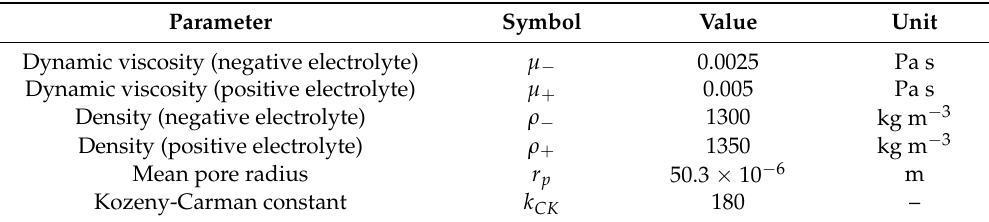
Table 5. Fluid model parameters from Knehr et al. [10].